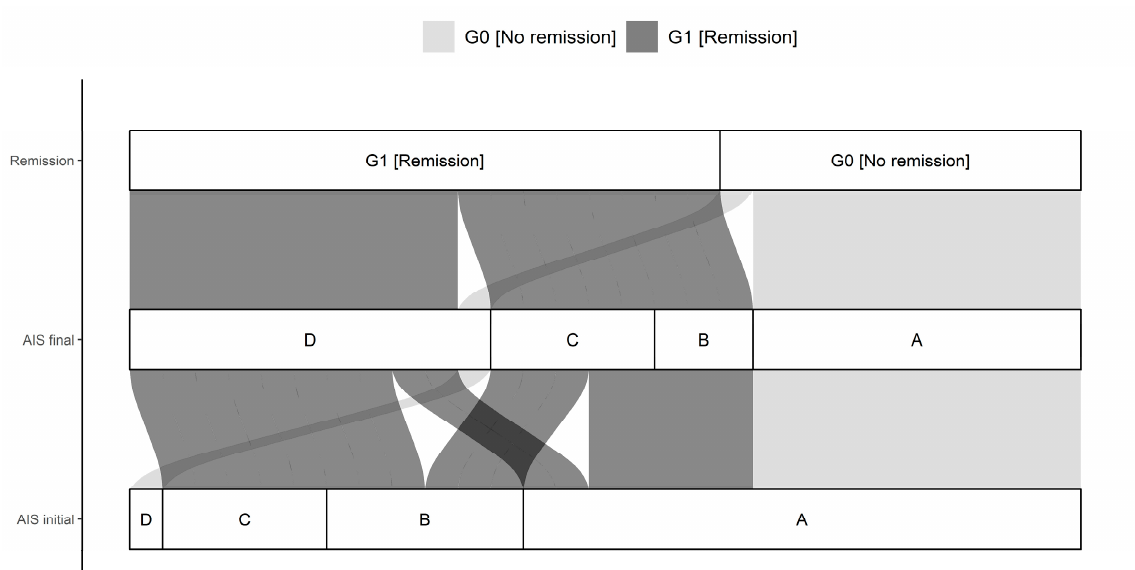
Figure 1. Distribution of initial AIS (association impairment scale) and final AIS in G0 and G1. The connections indicate the individual configuration of each patient with initial neurological impairment with respect to the initial and final AIS as well as the group assignment to either G0 or G1. Abb.: AIS initial = AIS level at admission, AIS final = AIS level 3 months after injury.